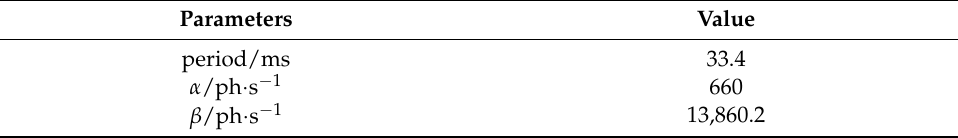
Table 4. Simulation parameters of Crab pulsar